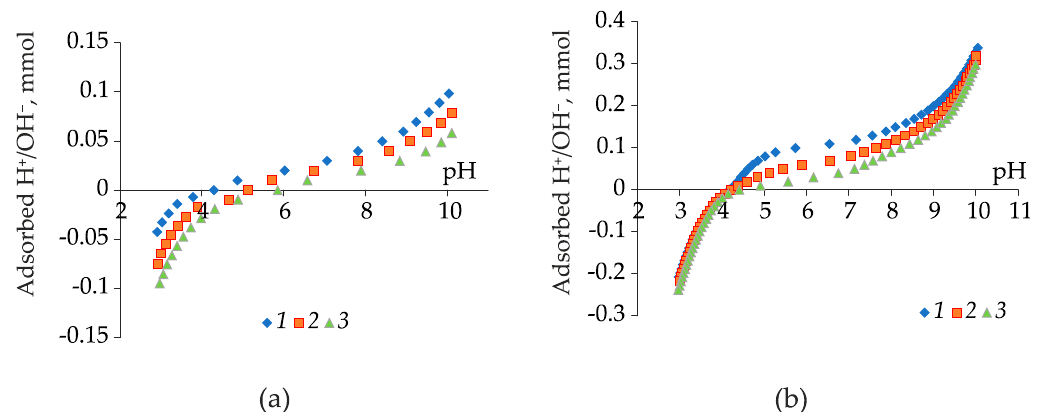
Figure 10. Dependence of the amount of adsorbed H + or OH − on the pH of Na- ( a ) and Al 13 -bentonite ( b ). NaCl concentration: 0.1 M ( 1 ), 0.01 M ( 2 ) and 0.001 M ( 3 ).